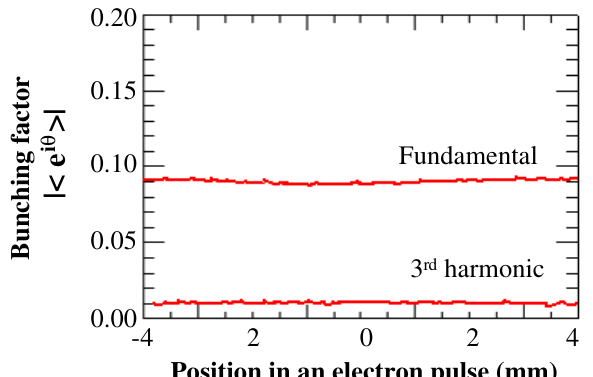
FIG. 6. (Color) Bunching factor of the fundamental and the third harmonic along a Gaussian electron pulse after 30 cm saturated FEL interaction inside the K (cid:3) 2 : 85 undulator with a 3 MW seed of wavelength 100 (cid:1) m .